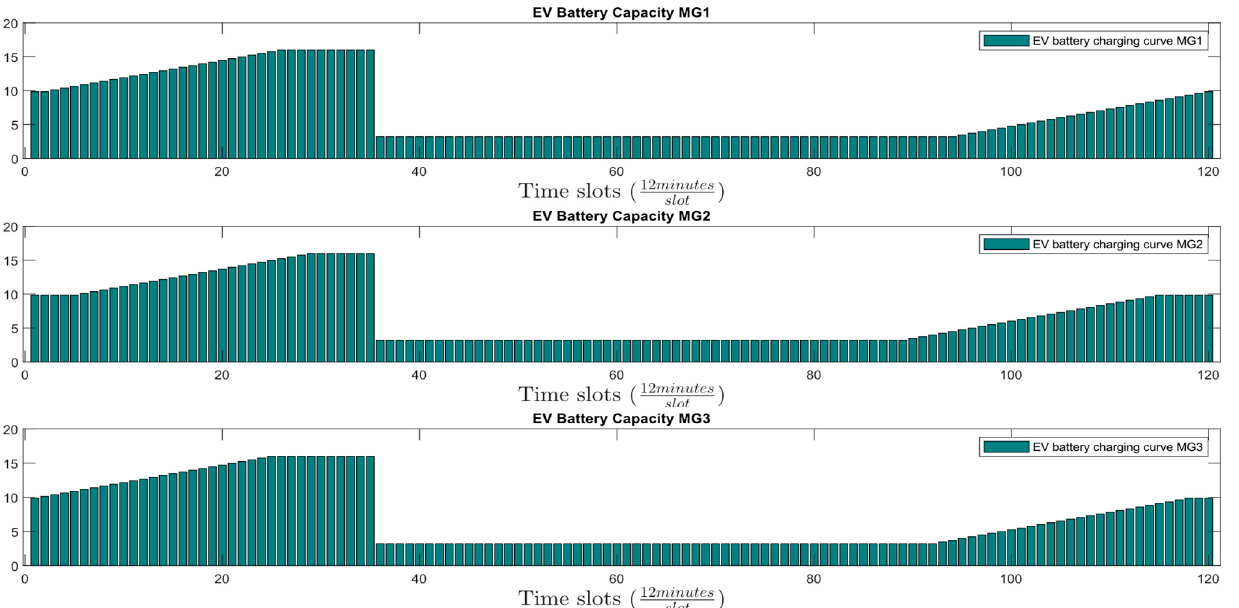
Figure 23. Scheduled load curve of MG 1 , MG 2 , and MG 3 using MJLBO for scenario 3.